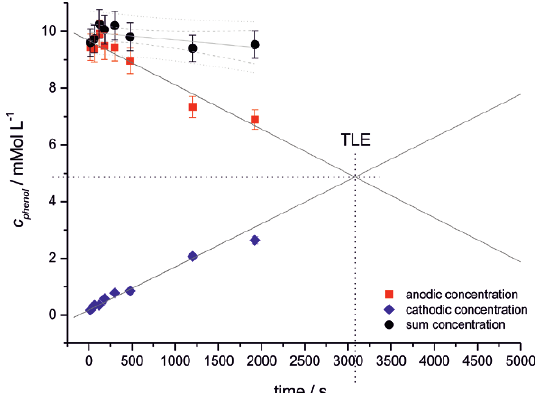
Figure 7. Exp. 2a: Transport of phenol from anode to cathode beaker. The grey dashed line marks the theoretical mixture concentration (5 mmol L -1 ); the black dashed lines show concentration and time at the theoretical linear equilibrium (TLE). The concentration sum is evaluated with a linear fit including 95% confidence (dashed) and 95% prediction (dotted)